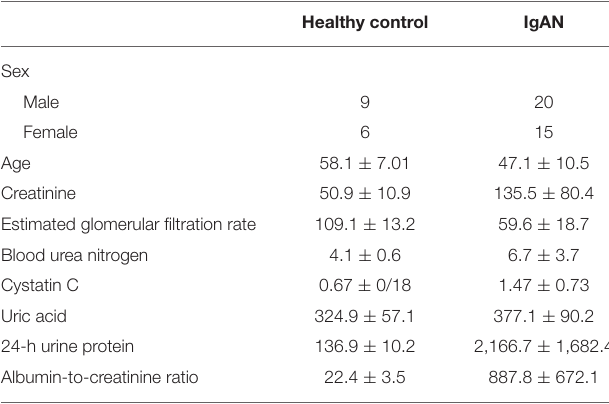
TABLE 6 | Demographic and clinical data of IgAN patients and healthy control subjects.